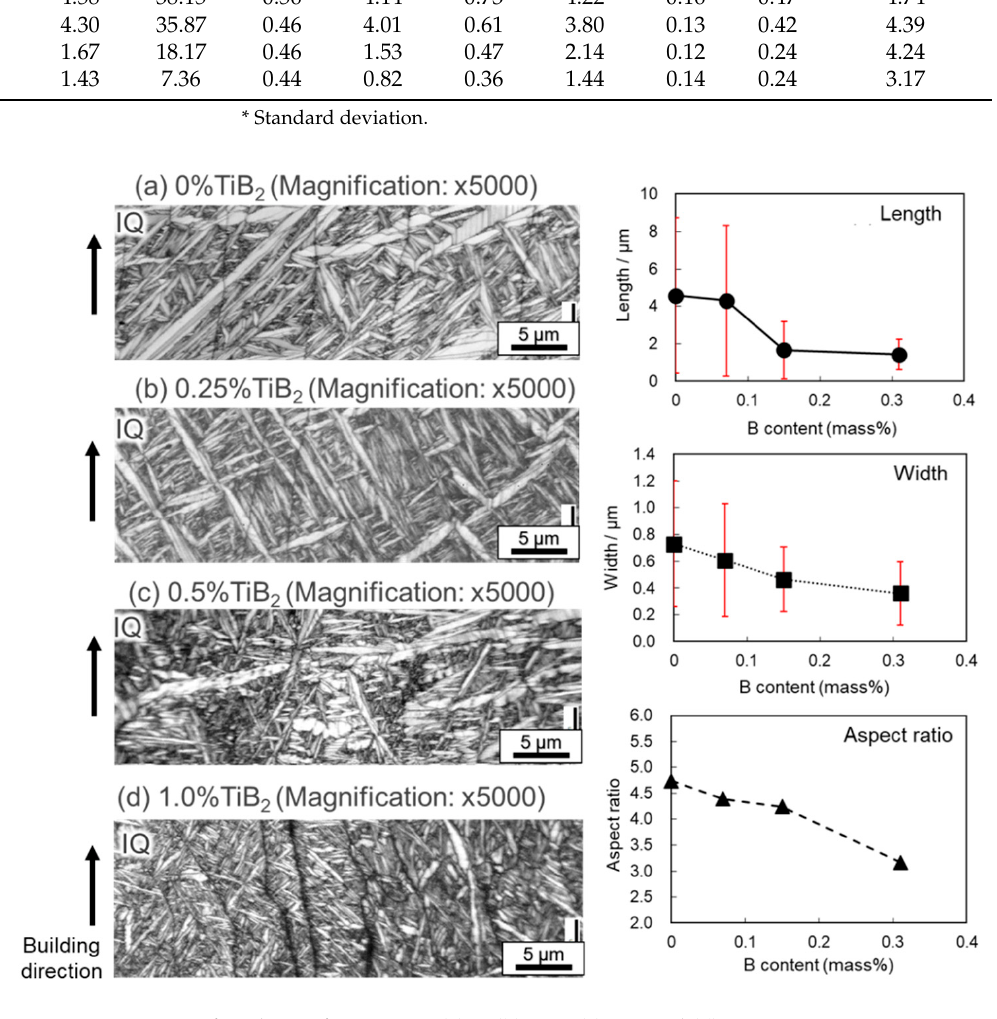
Figure 8. IQ maps of α -phase of SLM Ti64- ( a ) 0, ( b ) 0.25, ( c ) 0.5, and ( d ) 1.0 mass% TiB 2 composites and dependence of the length, width, and aspect ratio of the α′ -phase on B content for each sample.